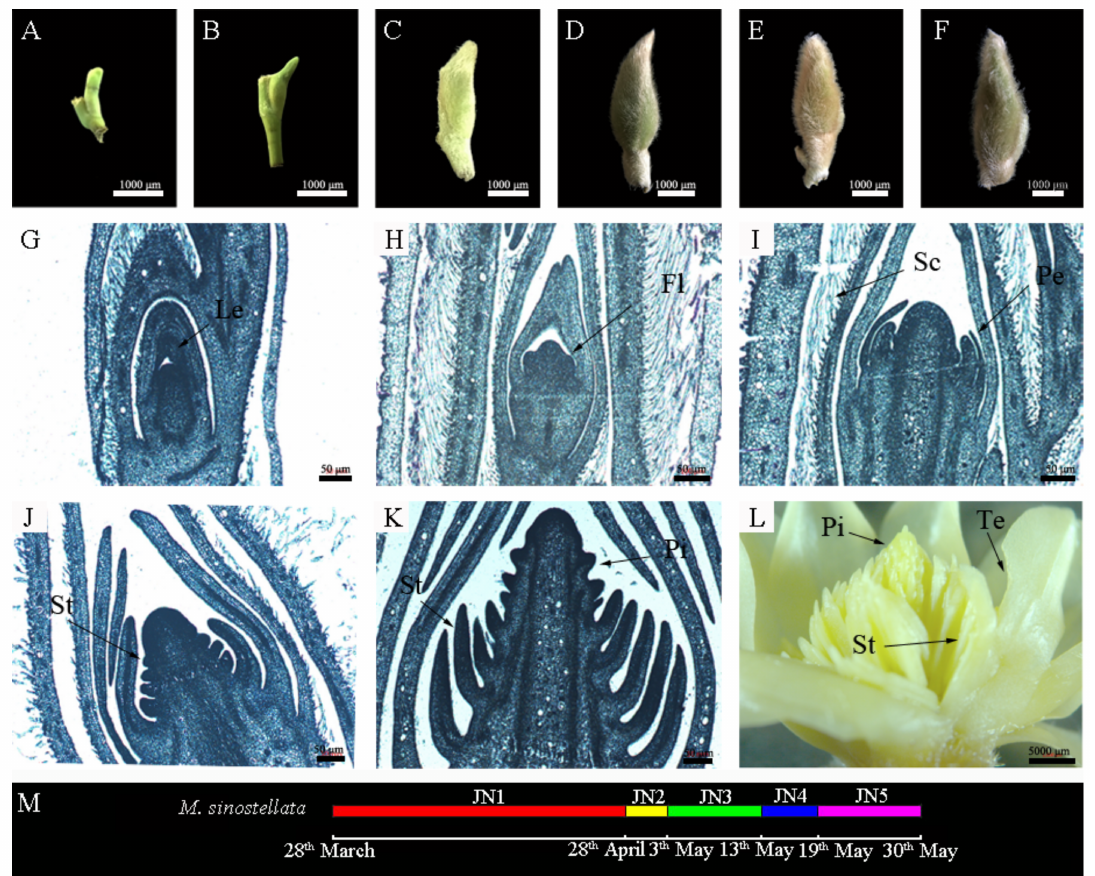
Figure 1. Morphological characteristics of the flower bud differentiation process in Magnolia